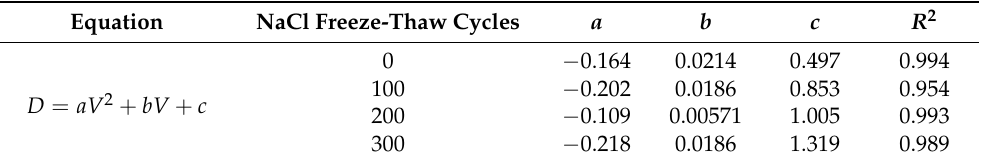
Table 5. The fitting results of basalt fibers volume and the carbonation depth.